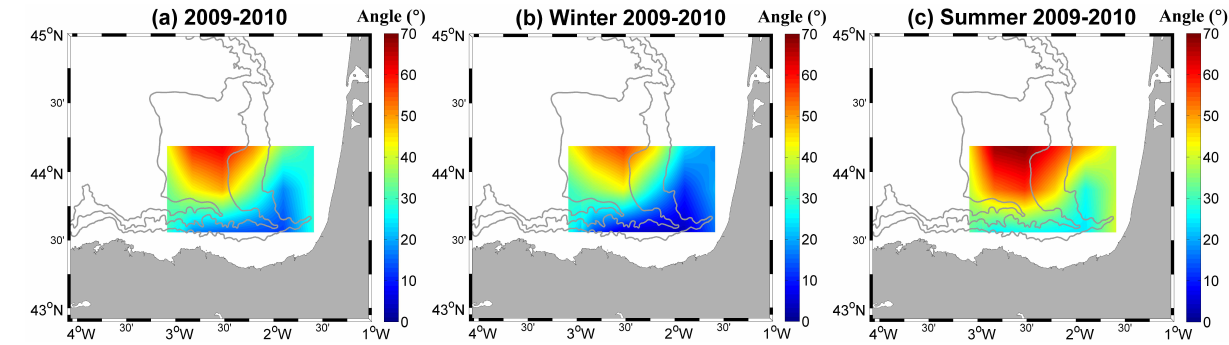
Fig. 6. Deflection angles of the wind-induced surface flows for the first CCA mode in: (a) 2009–2010, (b) wintertime (October to March) 2009–2010, and (c) summertime (April to September) 2009–2010 periods. Bathymetric contours show the 200-, 1000- and 2000-m